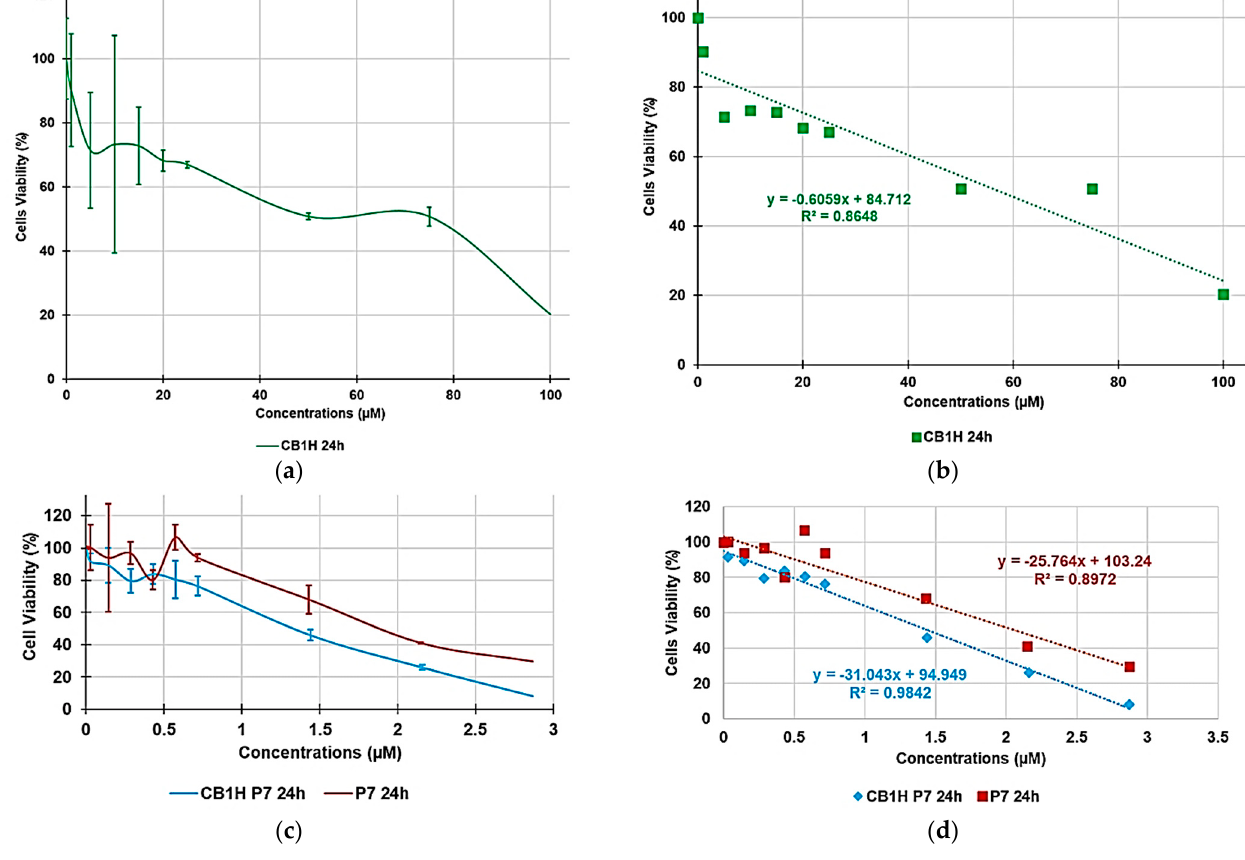
Figure 5. Curves of cell viability (%) vs. concentrations (1–100 µM) of CB1H ( a ) and vs. concentrations of CB1H-P7 NPs providing CB1H 1–100 µM, as well as vs. concentration of P7 as those allowed by the administered CB1H-P7 NPs ( c ) at 24 h towards HaCaT cells; linear regression models fitting the dispersion graphs obtained reporting in graph the cell viability % vs. the concentration of samples at 24 h of exposure of CB1H ( b ), P7 and CB1H-P7 NPs ( d ).